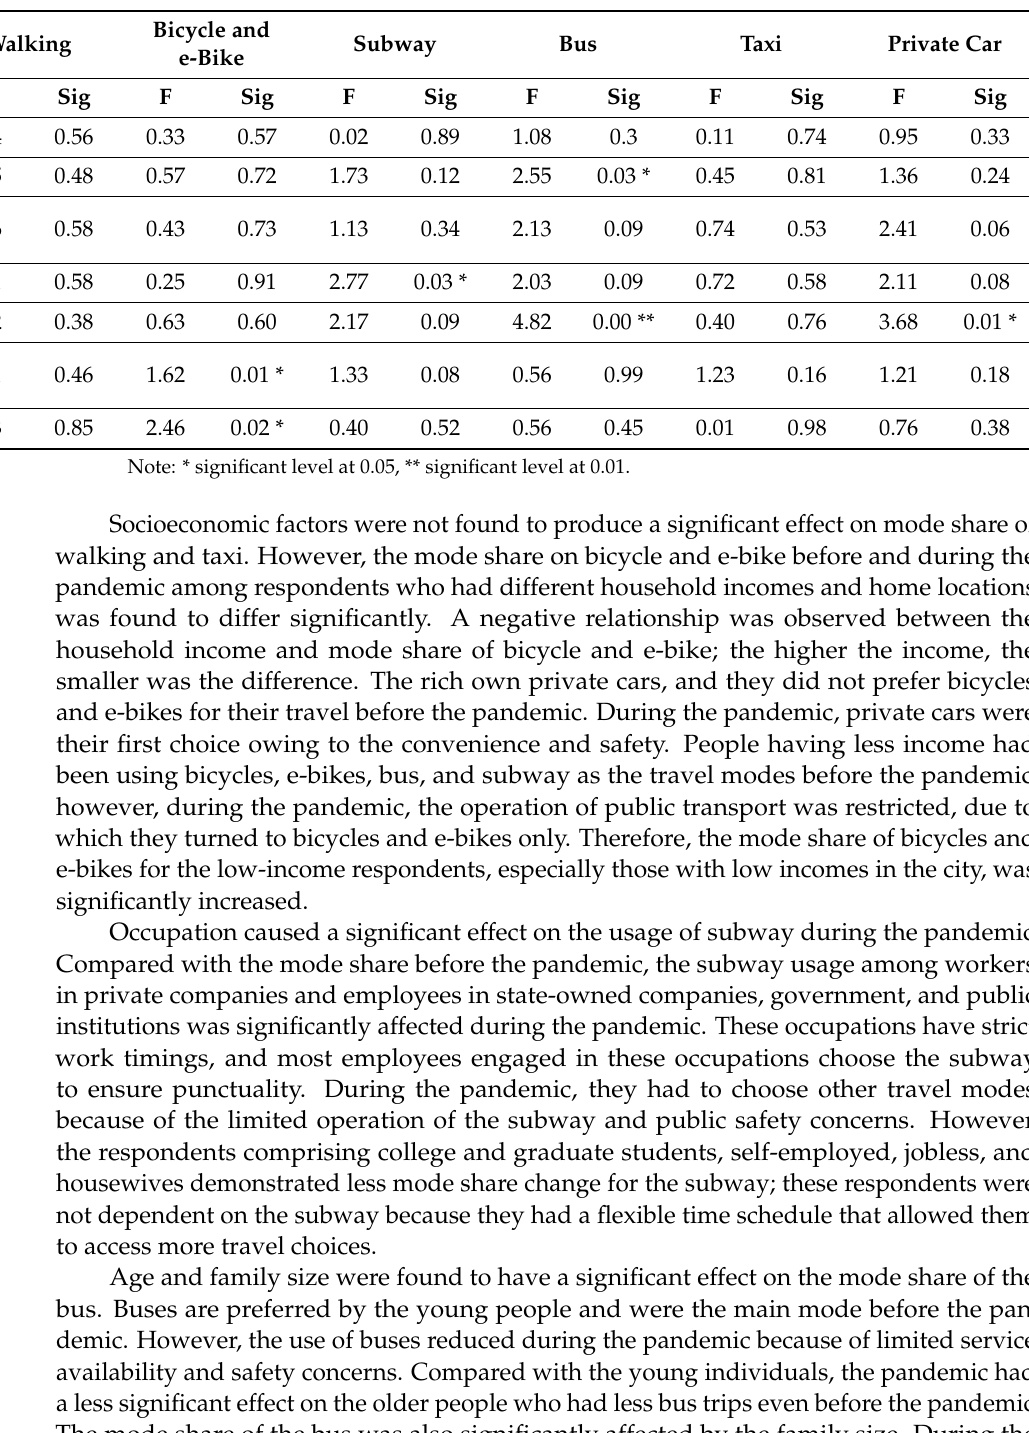
Table 6. Result of ANOVA for socioeconomic factors and mode share difference before and during the pandemic. Bicycle and Mode Share Subway Bus Taxi Walking e-Bike Difference